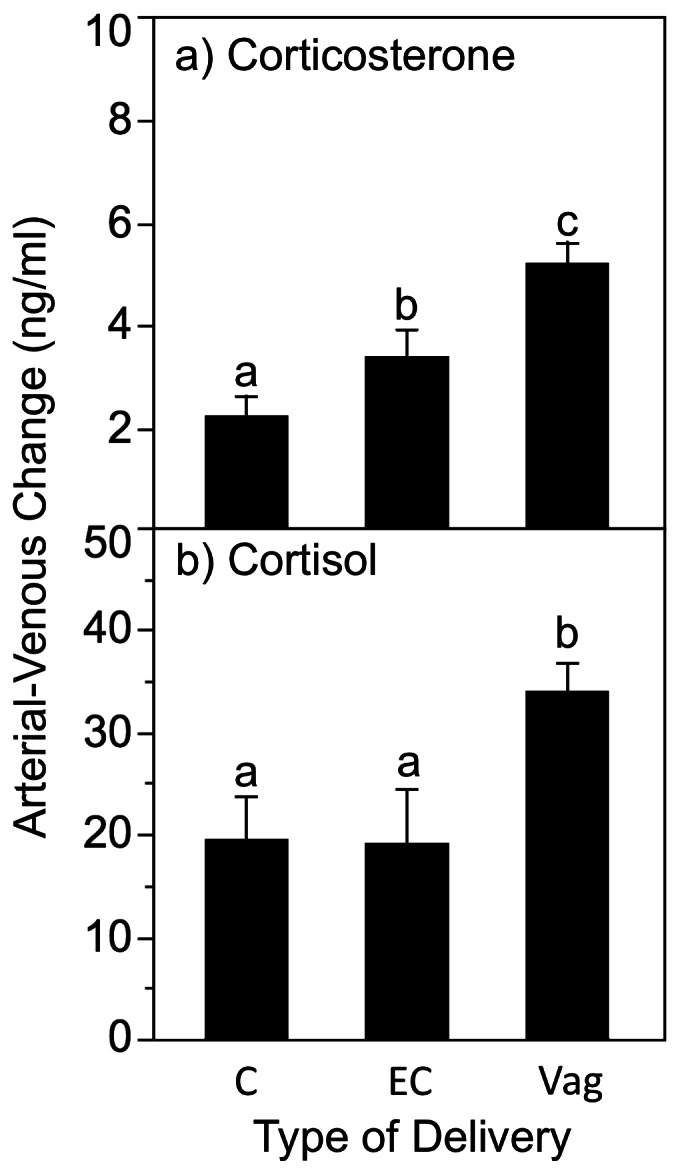
Absolute corticosteroid synthesis differences by delivery type.Absolute increase [A-V] ng/ml in concentration after passage of the fetus for corticosterone (panel a) and cortisol (panel b) across the three types of delivery: scheduled and emergent Caesarian sections (C, EC) and vaginal deliveries (Vag). Letters that differ indicate a significant post-hoc difference between groups following an overall effect of delivery type.